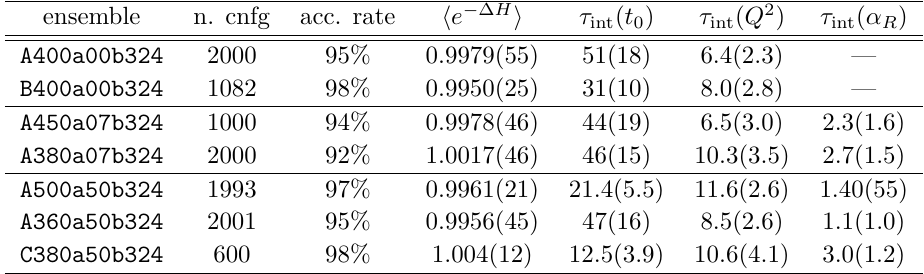
Table 2 . For each ensemble: the number of configurations which corresponds to the number of MD trajectories, the acceptance rate, the diagnostic observable h e − ∆ H i = 1 , the integrated autocorrelation times (in units of MD trajectories) for the scale t 0 /a 2 , the squared topological charge Q 2 , and the renormalized fine-structure constant α R . One MD trajectory is equal to τ = 2 MD units. phase transition. In the conventions of [62], our largest value of α = 0 . 05 corresponds